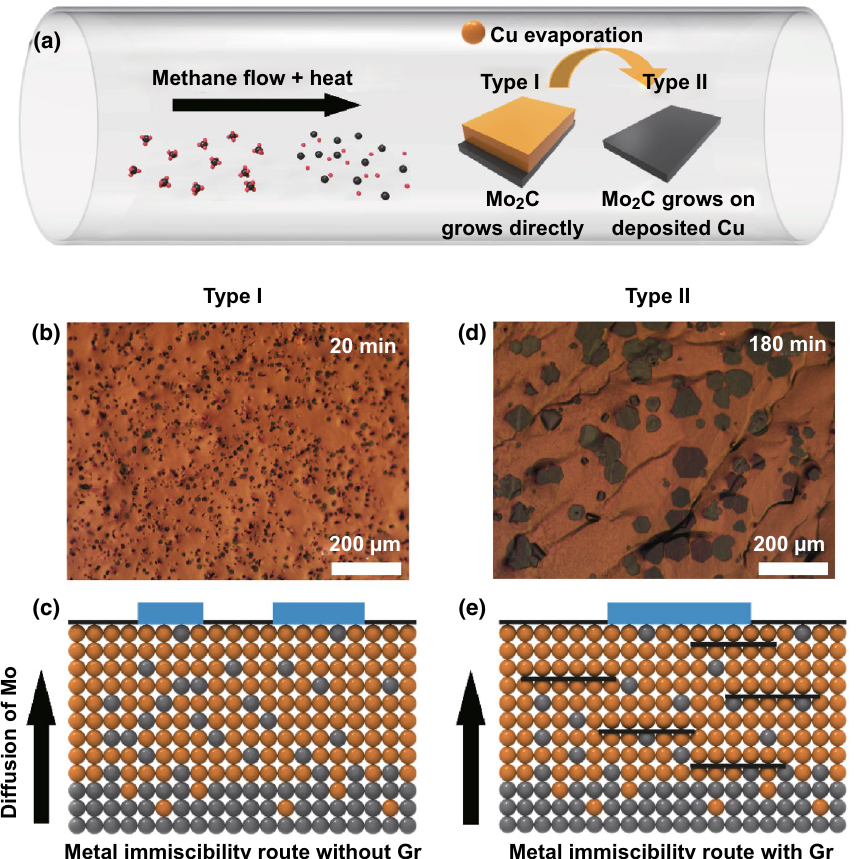
Fig. 2 a Schematic diagram of the CVD method to grown Mo 2 C. In the type I method, copper foil is placed on molybdenum foil to directly grow molybdenum carbide. In the type II method, the molybdenum foil is placed near the copper foil. Copper evaporates at high temperatures and adsorbs on the molybdenum foil for the growth of Mo 2 C. b Optical image of Mo 2 C prepared by the type I method with a growth time of 20 min. c Schematic diagram of the type I Mo 2 C growth process. d Optical image of Mo 2 C prepared by the type II method. e Schematic diagram of the type II Mo 2 C growth process. The black line represents